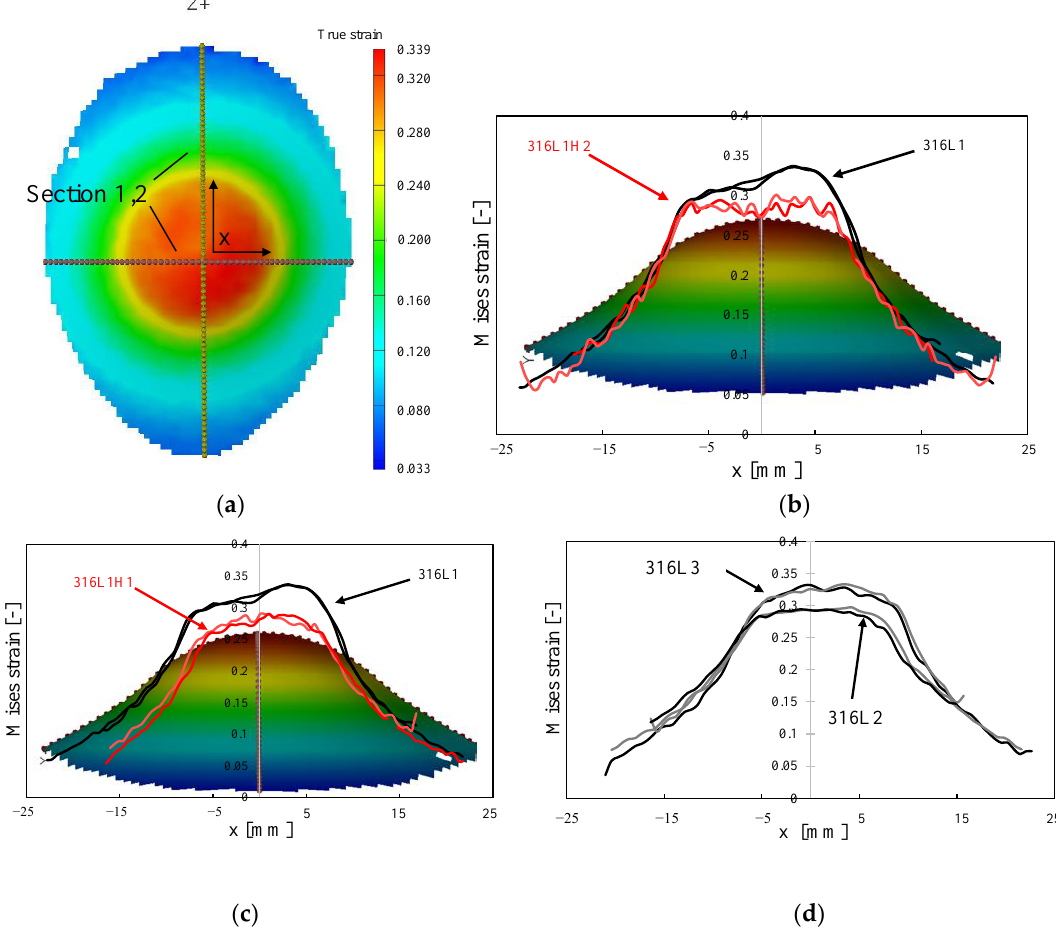
Figure 12. Distribution of von Mises strain determined over two section cuts in the biaxial stretch forming samples. ( a ) Strain contour on the biaxial sample for the as received 316L1 condition with the two section cuts shown. ( b ) Comparison of the strain distribution for 316L1 and 316L1_H2. ( c ) Comparison of the strain distribution for 316L1 and 316L1H1. ( d ) Comparison of strain distribution for commercial alloys 316L3 and 316L2.